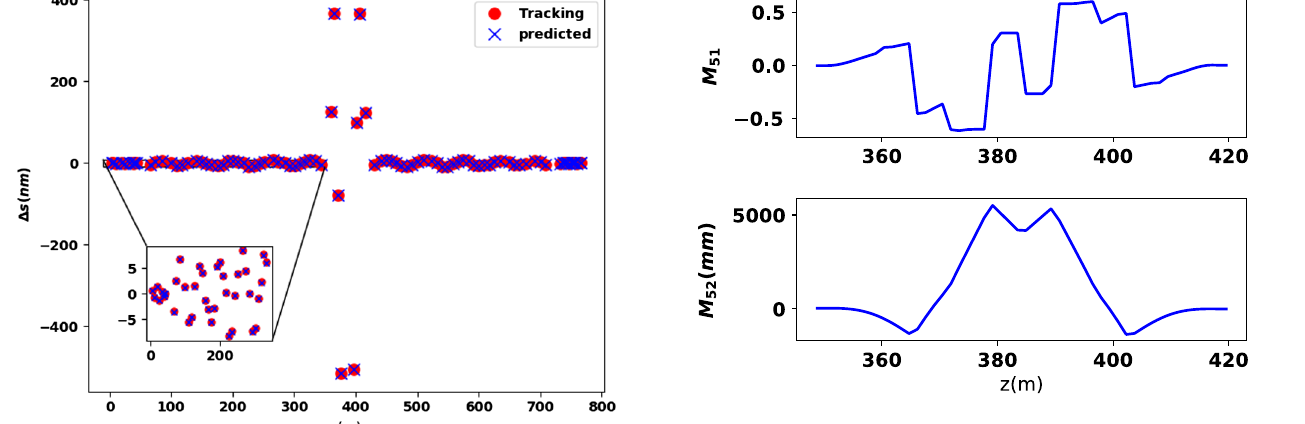
FIG. 5. Transfer elements M 51 ð z Þ and M 52 ð z Þ computed from a location in the arc bypass to the KU ¼ 10 − 5 . err